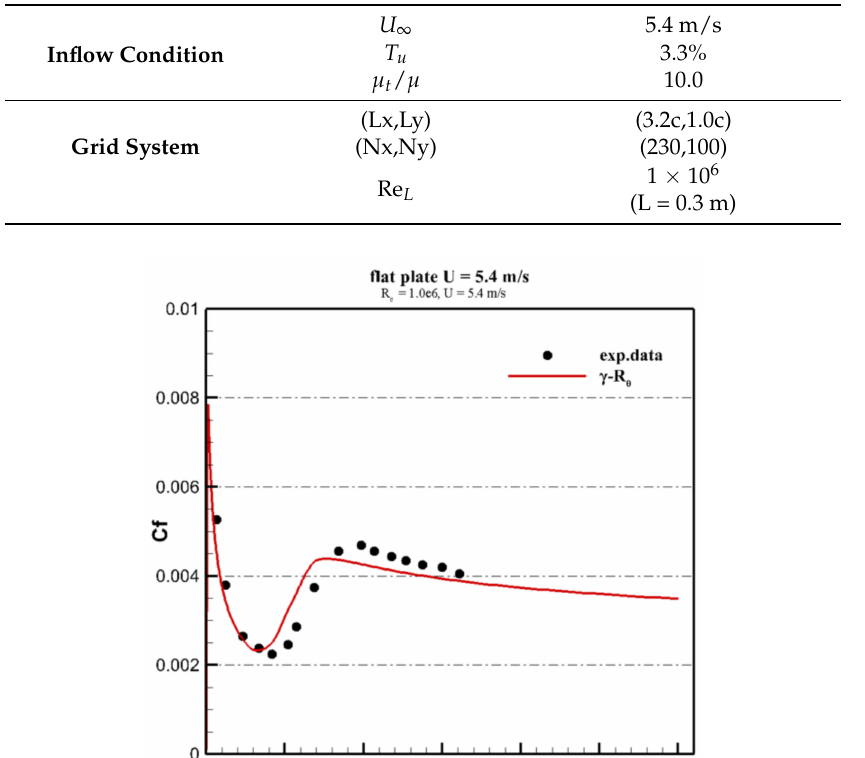
Figure 1. Computational mesh for the flat plate. Table 4. Information regarding the inflow conditions and grid system for flow over a flat plate.